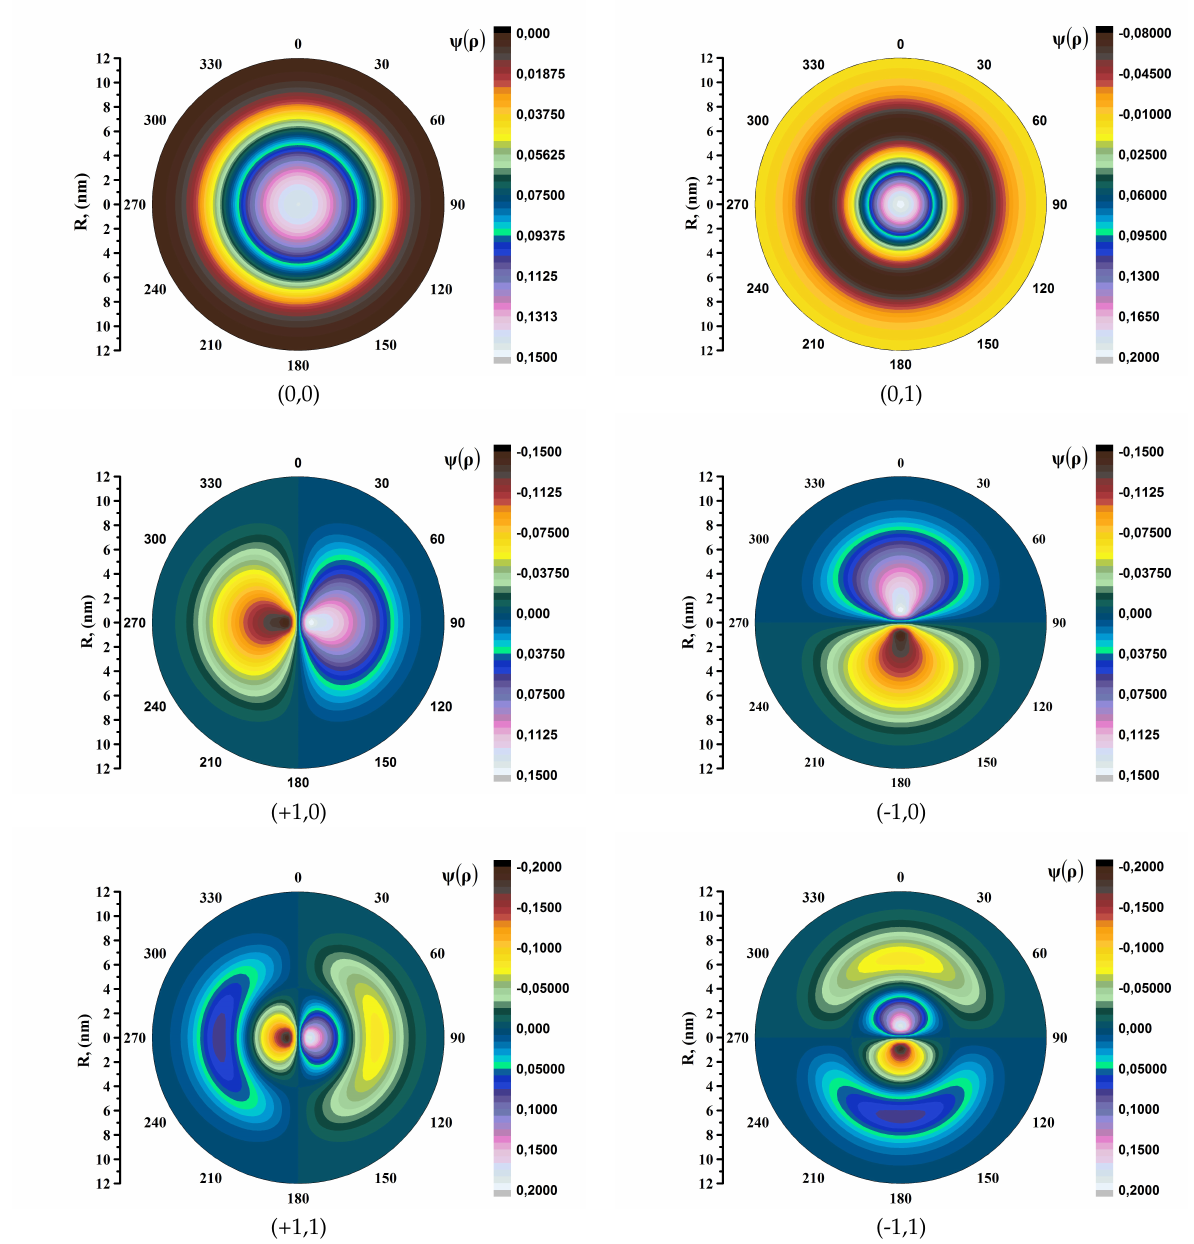
Fig. 5. Dependence of the wave function of electrons of a cylindrical nanowire with a finite potential well on the size of the